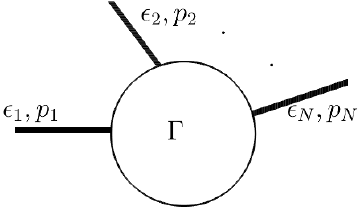
Figure 3 . The amplitude without the soft